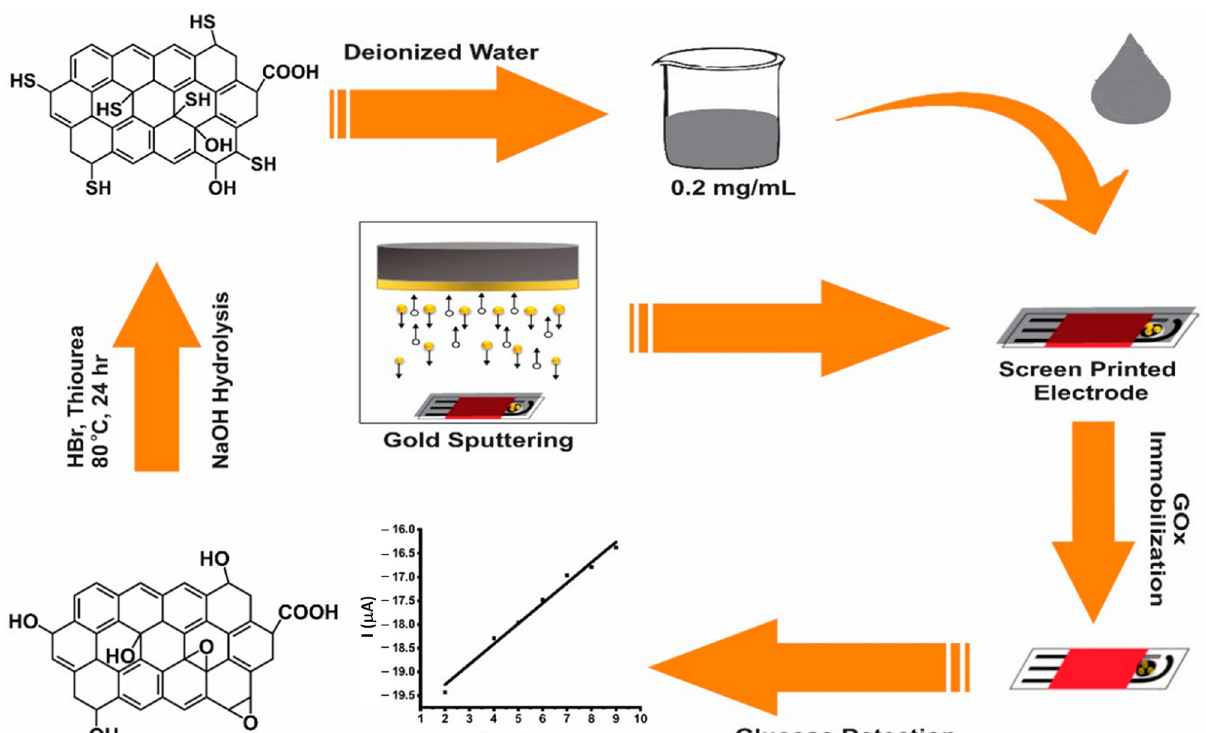
Figure 12. Schematic illustration of the GO-SH synthetic pathway to GOx-GO-SH-Au-SPE interface construction for glucose detection (adapted and reprinted with permission from [153]).